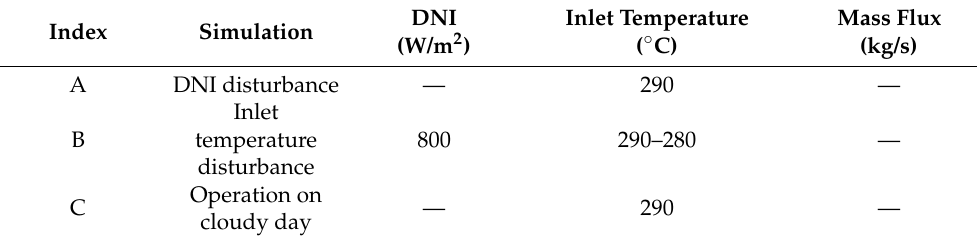
Table 3. Boundary conditions of each case.